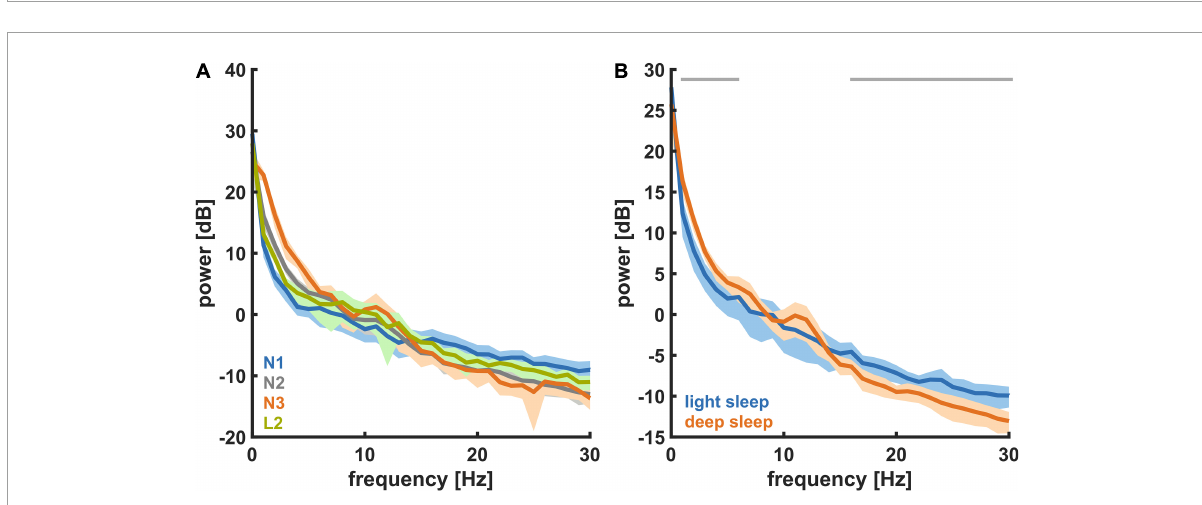
FIGURE3 Power spectral density (PSD) for the different NREM sleep states recorded at baseline ( n = 18). (A) For different levels of NREM sleep, i.e., N1, L2, N2, and N3. (B) For light sleep and deep sleep . During deep sleep the power in the low (delta) frequencies was significantly higher and the power in the high (beta) frequencies was significantly